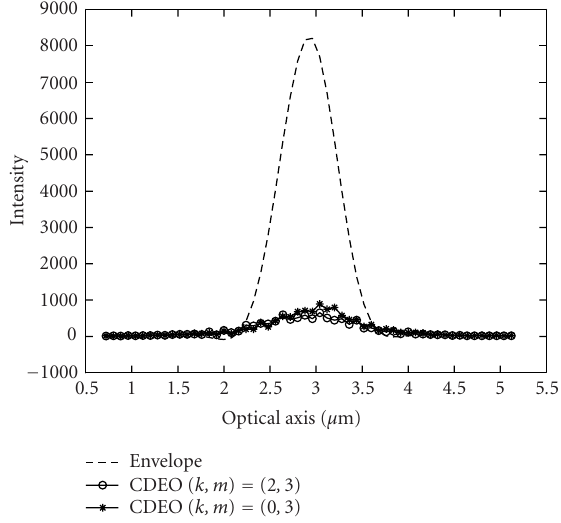
Figure 8: Typical envelope and CDEO applied to a noisy signal.